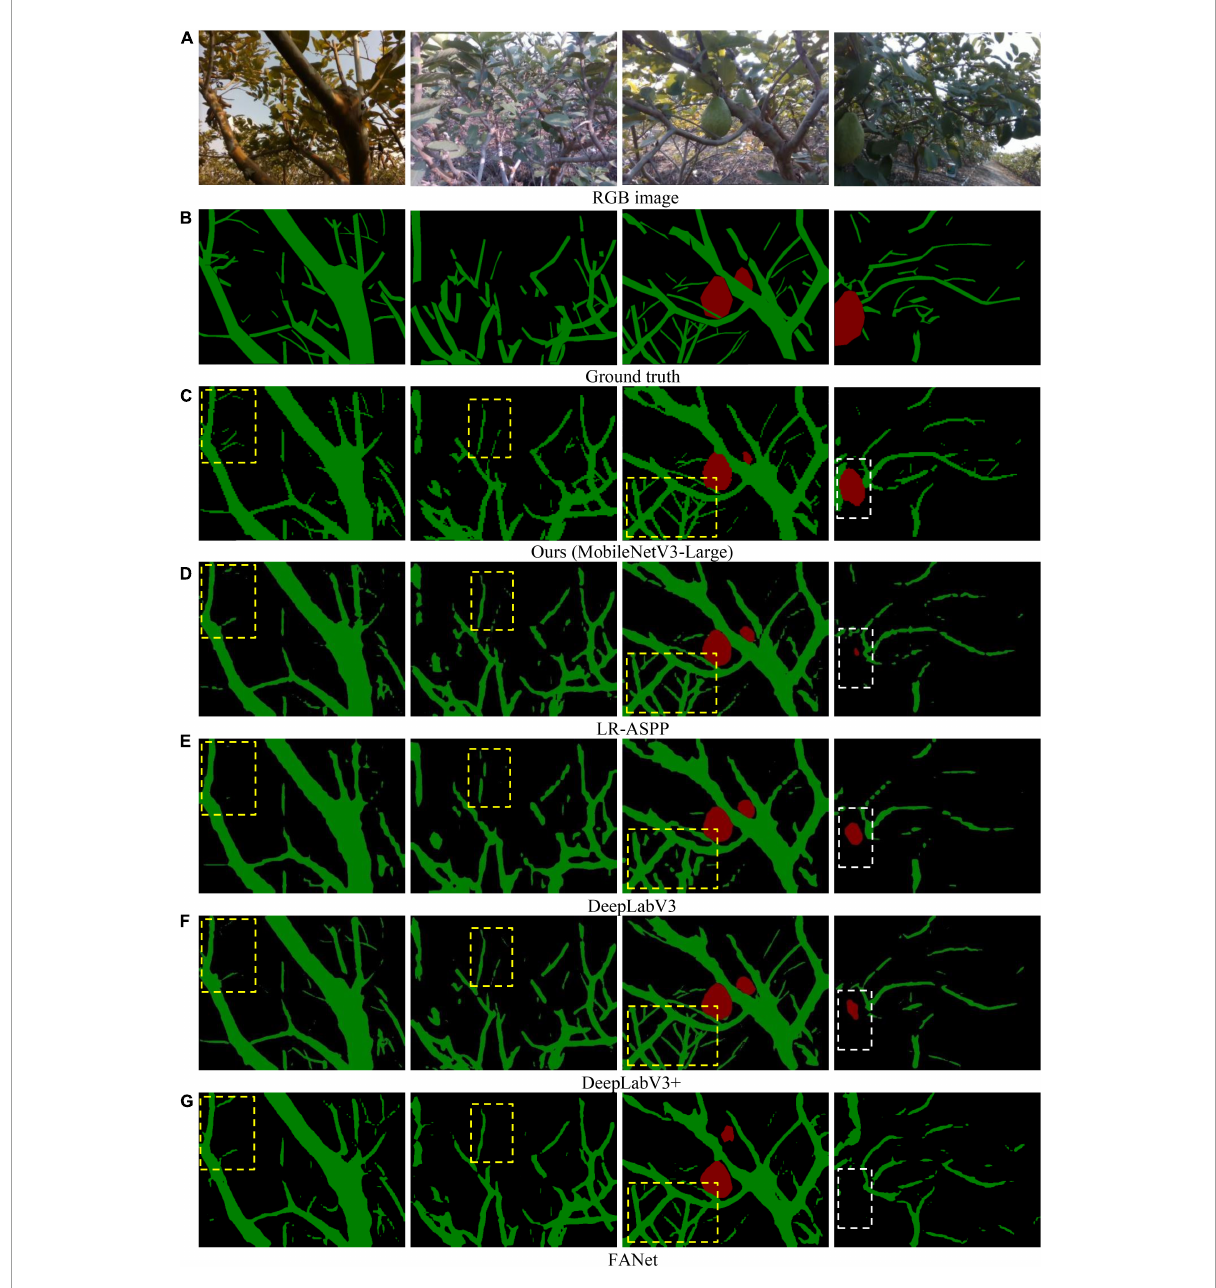
FIGURE6 Visual examples illustrating results of our network and comparison networks. (A) RGB image. (B) Ground truth. (C) Ours (MobileNetV3-Large). (D) LR-ASPP. (E) DeepLabV3. (F) DeepLabV3+. (G) FANet.